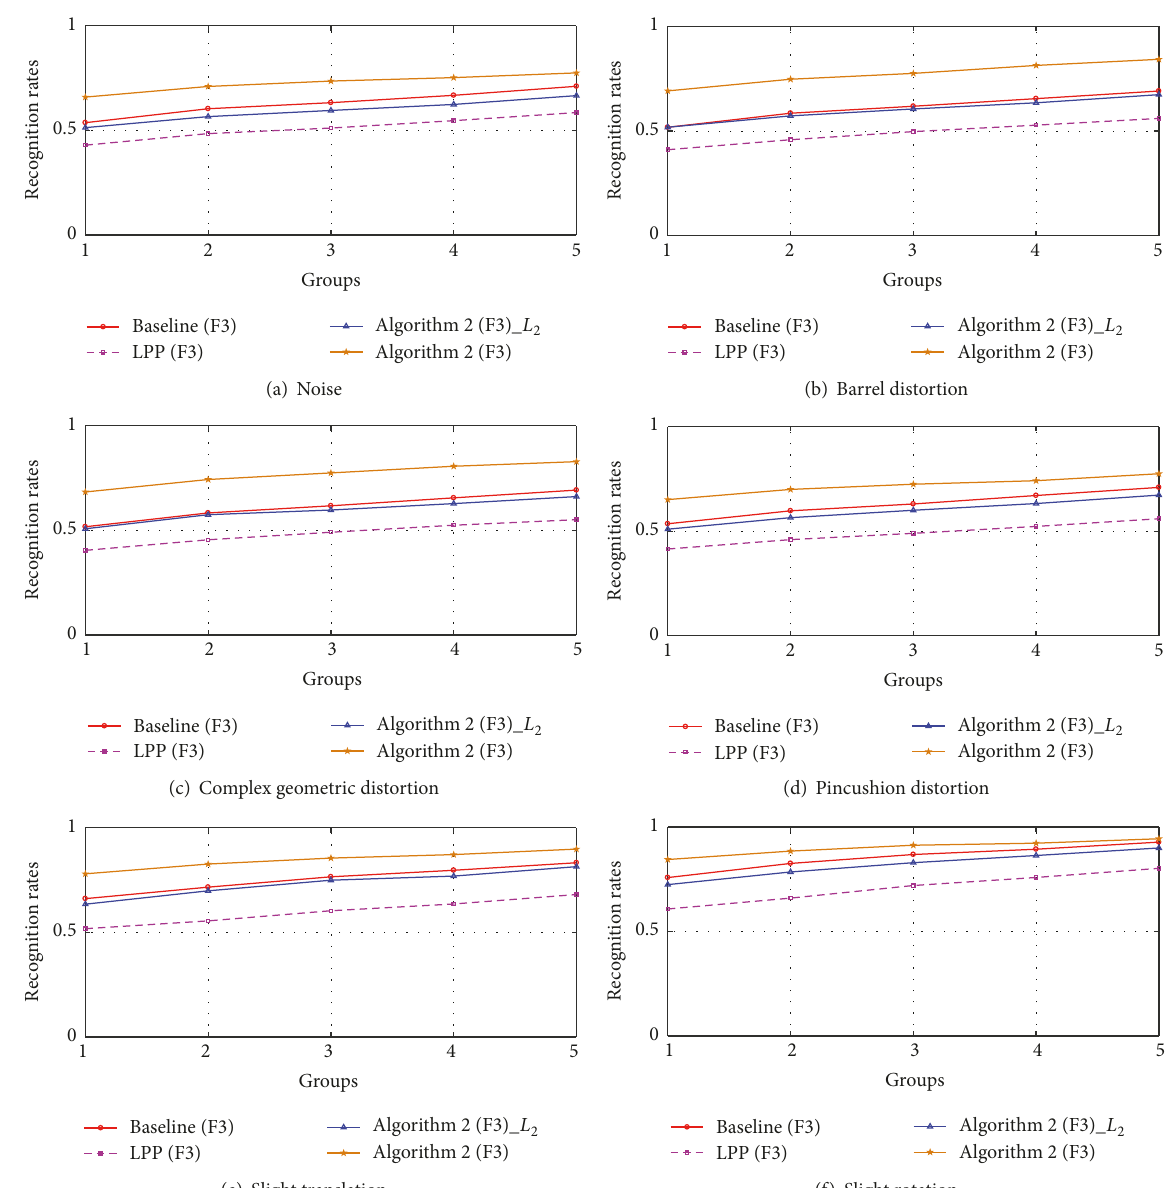
Figure 12: The recognition rates on noise, geometric distortion, slight translation, and slight rotation AR face databases over “F3” features.